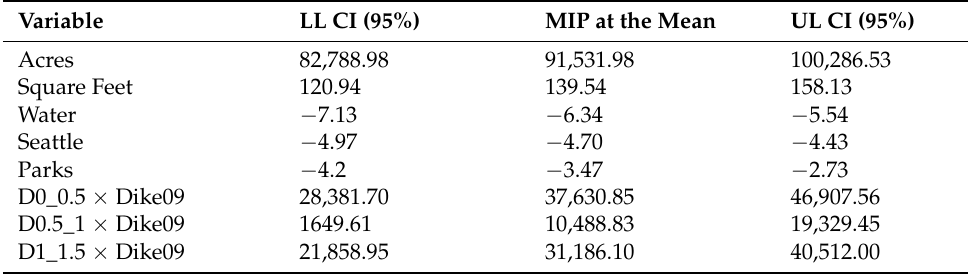
Table 4. Marginal Implicit Price (MIP) of Select